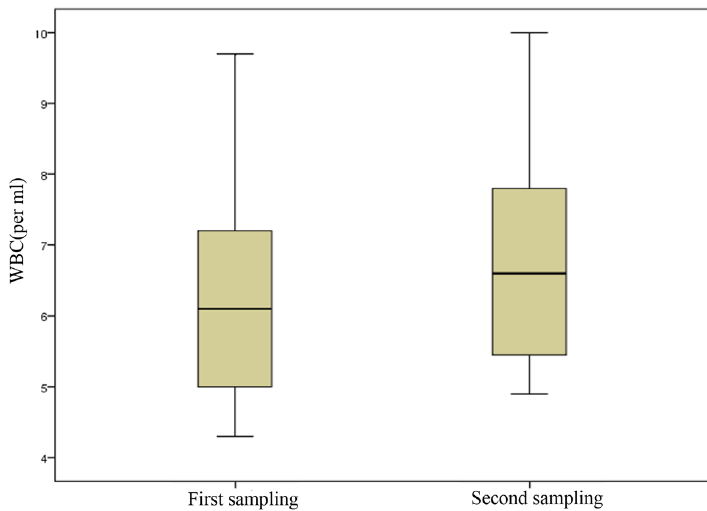
Figure 6. The concentration of WBC in blood in two sampling periods.